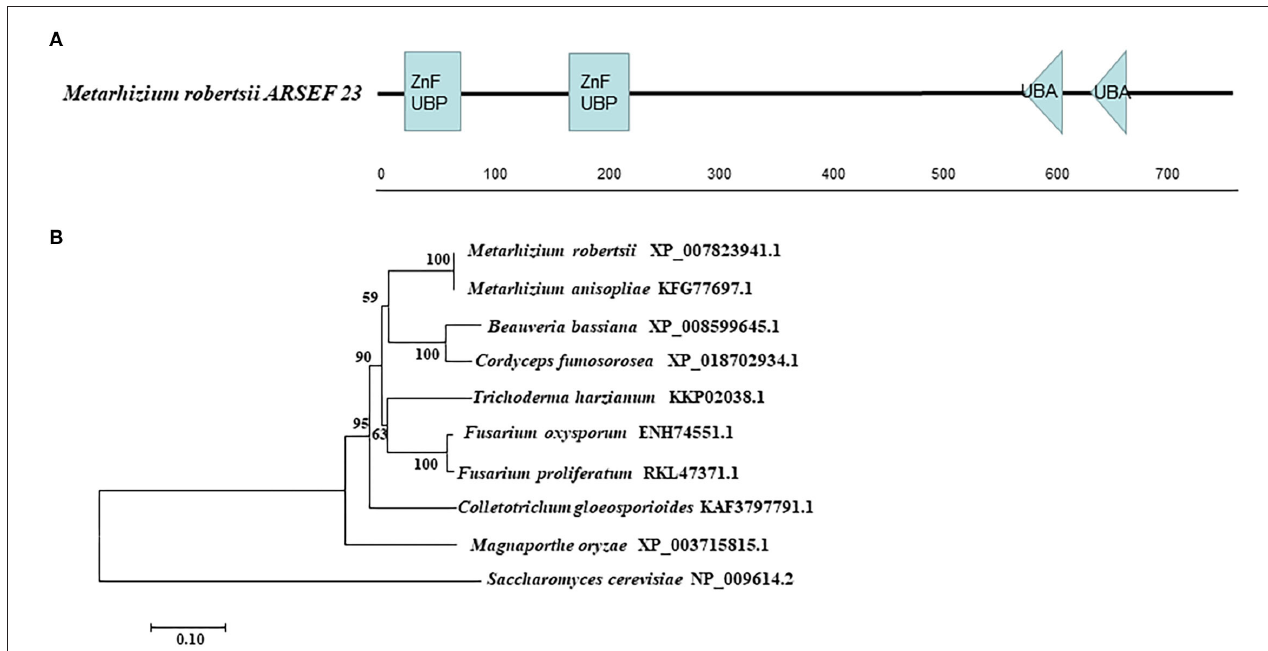
FIGURE 1 | Sequence analysis of MrUbp14. (A) Conserved domain analysis of MrUbp14. ZnF_UBP, UBP-type Zinc finger domain. UBA, ubiquitin-associated domains. (B) Phylogenetic tree of MrUbp14 with their homologs. The phylogenetic analysis was obtained by the maximum likelihood method (using MEGA7 software based on default settings with 1,000 bootstrap replications). The corresponding accession numbers are followed by the names of fungal species. The bar indicates 0.1 distance